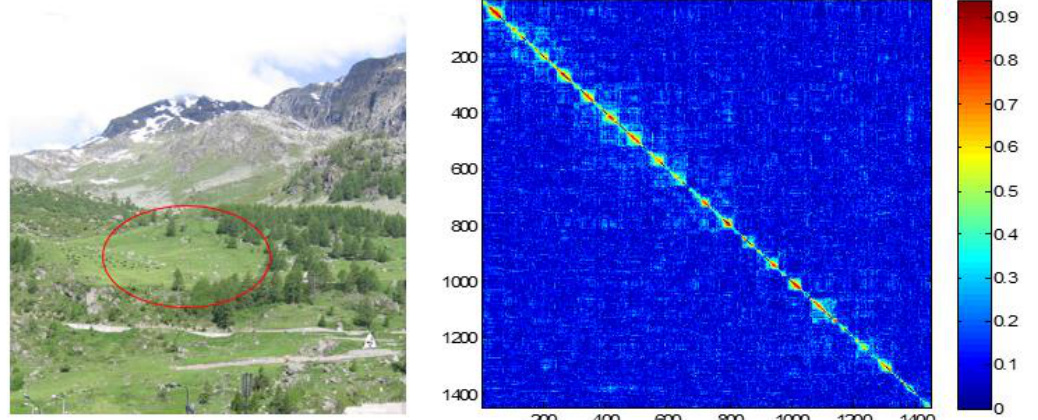
Figure 4. Multi-temporal coherence matrix, on the right, of the meadow encircled in red on the photo on the left, made by the position of the Ku-band (17 GHz) GBR. Numbers on the axis refers to the acquisitions, made every 20 min, starting from 20:05 of 18 June 2008. Coherence is found nighttime and not recovered from time to time.